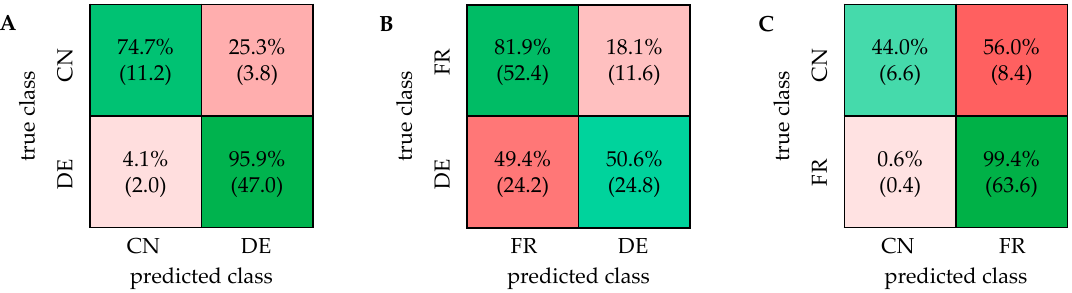
Figure 5. Confusion matrices for the classification of all two-class models based on the PSYCHE spectra. CN: China; DE: Germany; FR: France. Accuracies: ( A ): 90.9% (±1.5%); ( B ): 68.3% (±2.8%); ( C ): 88.9% (±1.2%).